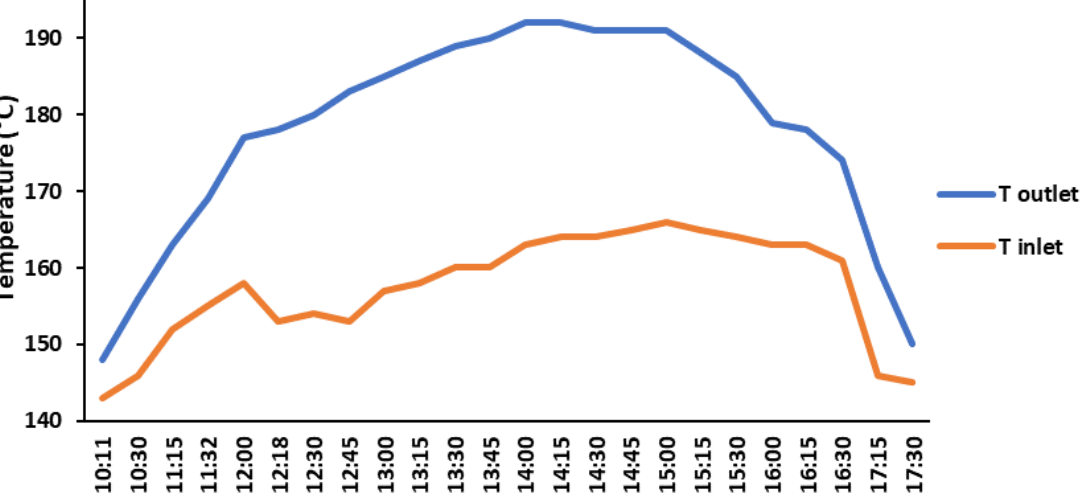
Figure 8. Heat loss power to maintain the tank at a temperature of 150 °C, depending on the ambient temperature.